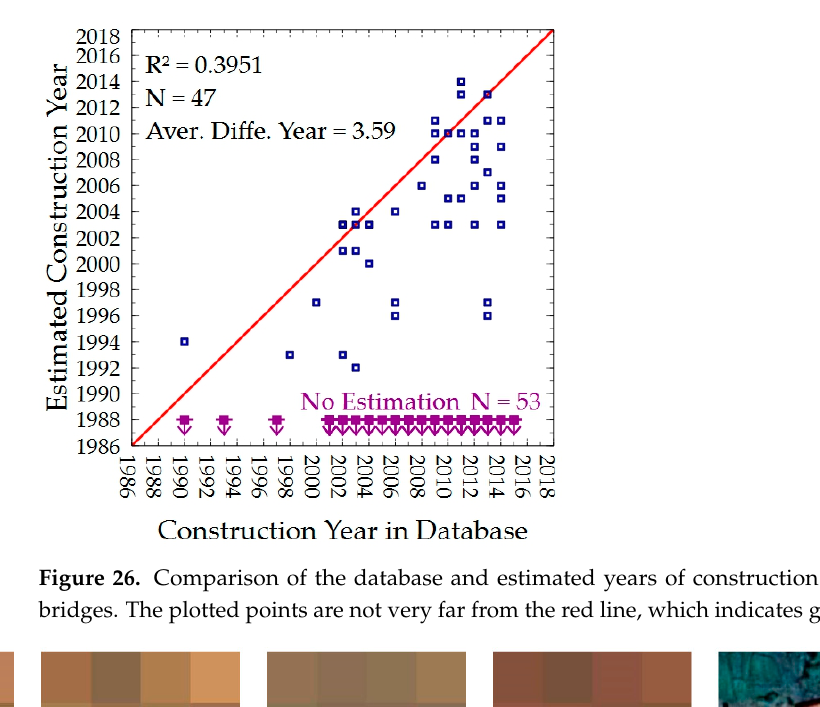
Figure 26. Comparison of the database and estimated years of construction of the 100 medium bridges. The plotted points are not very far from the red line, which indicates good accuracy.